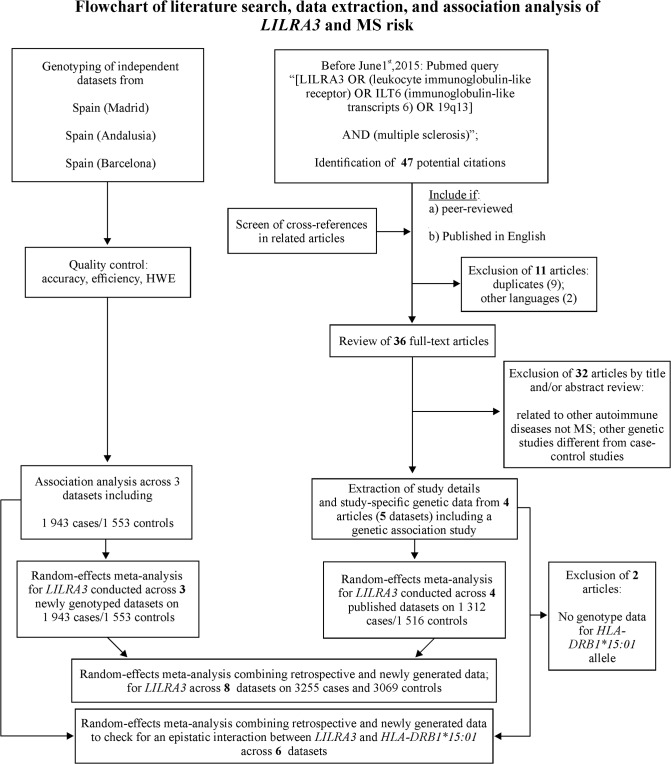
Flowchart of literature search, data extraction and association analysis of LILRA3 and MS risk.